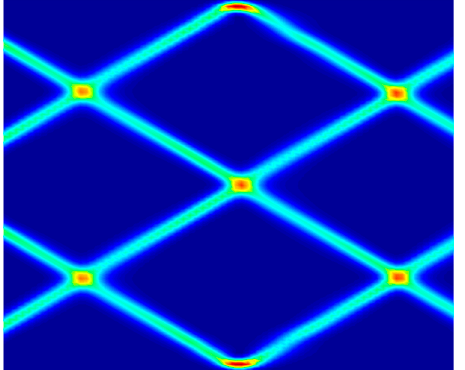
Figure 8. Perfectly balanced SNN network. At this stage, the network is ready to accept input infor- mation and change according to them. information and change according to